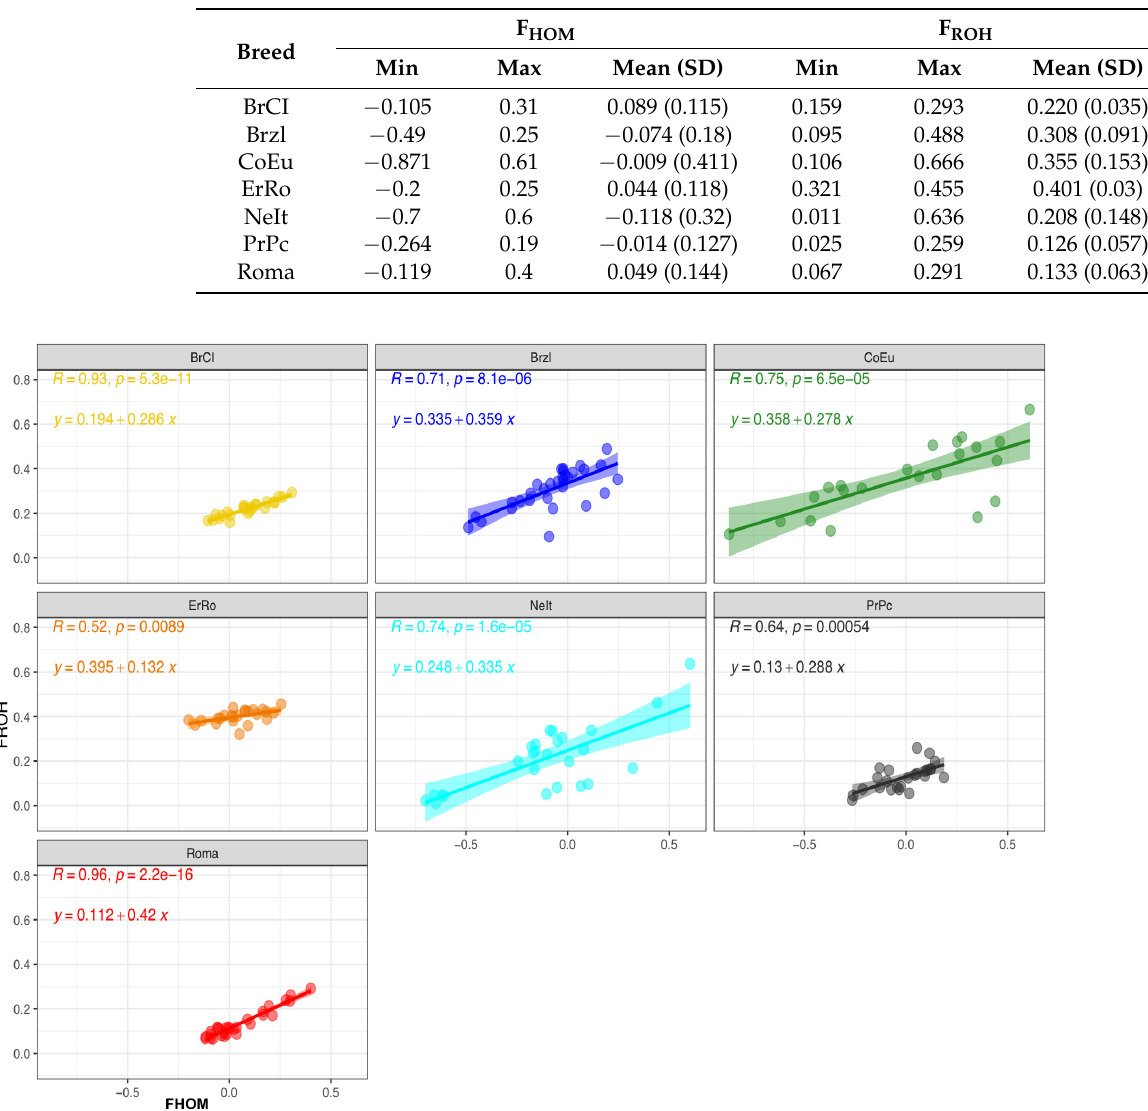
Table 4. Descriptive statistics for inbreeding coefficients F HOM and F ROH .